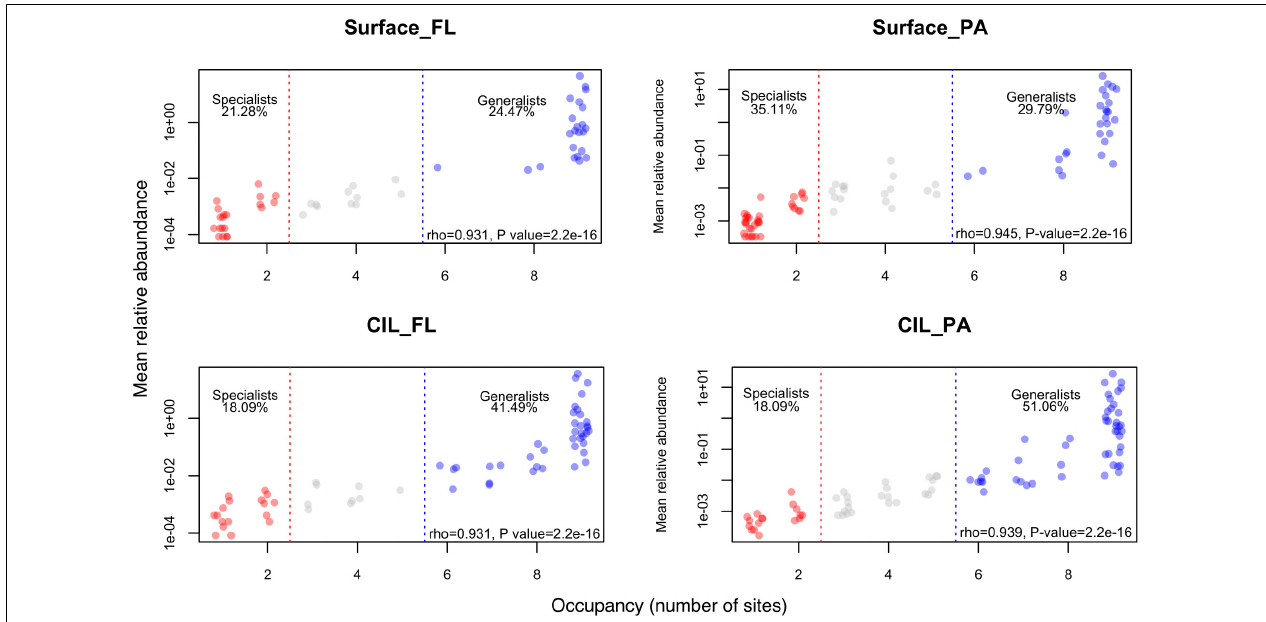
FIGURE 4 | Frequency of occurrence plotted against the mean relative abundance at the class level. The number of occupied sites was used to define the niche breadth of bacteria. Taxa that occupied fewer than two stations were defined as habitat specialists (red), and those occupying more than five stations as habitat generalists (blue), and those not classified as either ecological group (gray). The proportion of the two ecological groups is also shown. The correlation coefficient and P value obtained in the Spearman correlation analysis are presented in the lower right corner of each